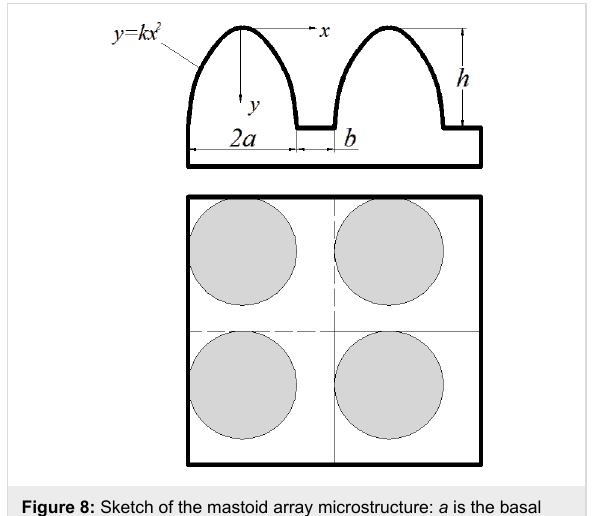
Figure 8: Sketch of the mastoid array microstructure: a is the basal diameter of a single mastoid, b is the space between two mastoids and h is the height of the mastoid.